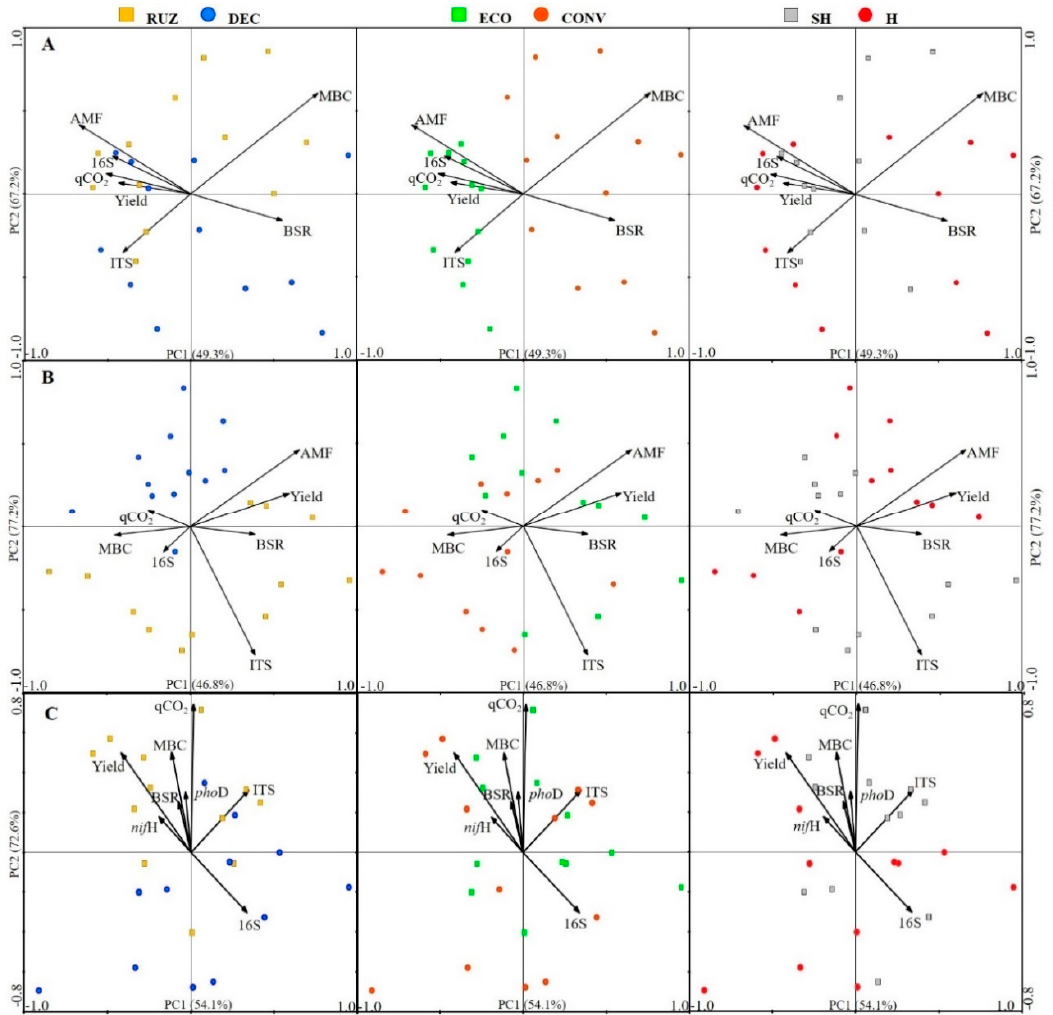
Figure 8. Redundancy analysis based on biplot distance from the bacterial community (Bray–Curtis) in a Tahiti acid lime orchard, under testing with different cover crops, mowers, and the use of glyphosate (Mogi Mirim, São Paulo, 2016–2019). Legend: RUZ = Urochloa ruziziensis (yellow squares), DEC = U. decumbens (blue circles), ECO = ecological mower (green squares), CONV = conventional mower (orange circles), H = glyphosate herbicide (1080 g ae. ha − 1 ) (red circles), NH = no herbicide (gray squares). Orchard age: growing season, 2016–2017 ( A ), 2017–2018 ( B ) and 2019–2020 ( C ).